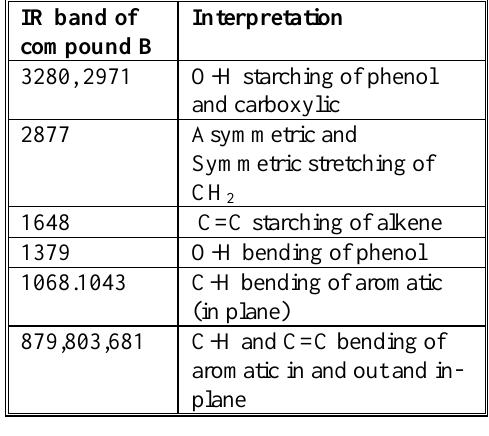
Figure 11. IR spectrum for compound B Table2 .The FTIR spectrum regions indicated the major functional groups in compound B